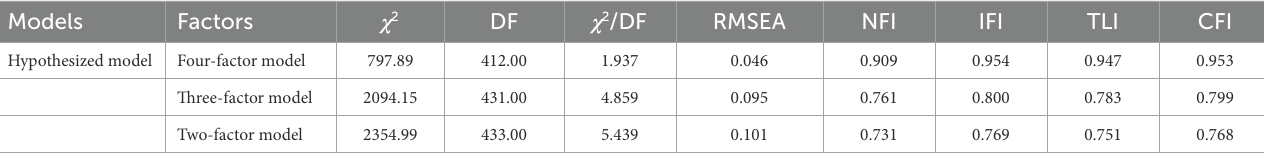
TABLE 1 Confirmatory factor analyzes of the measurement model.